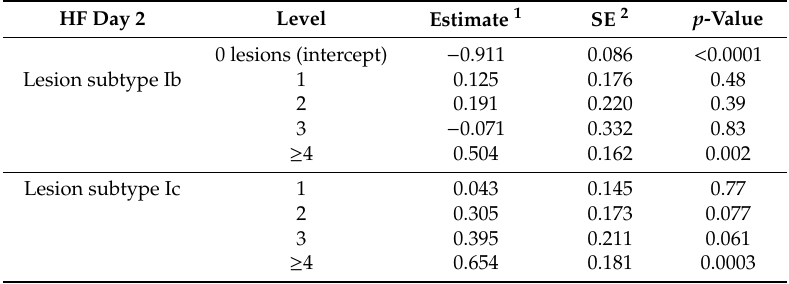
Table 6. Multivariable logistic regression of Hemo-Fec ® (HF) Day 2 test results in relation to abomasal lesion subtypes Ib and